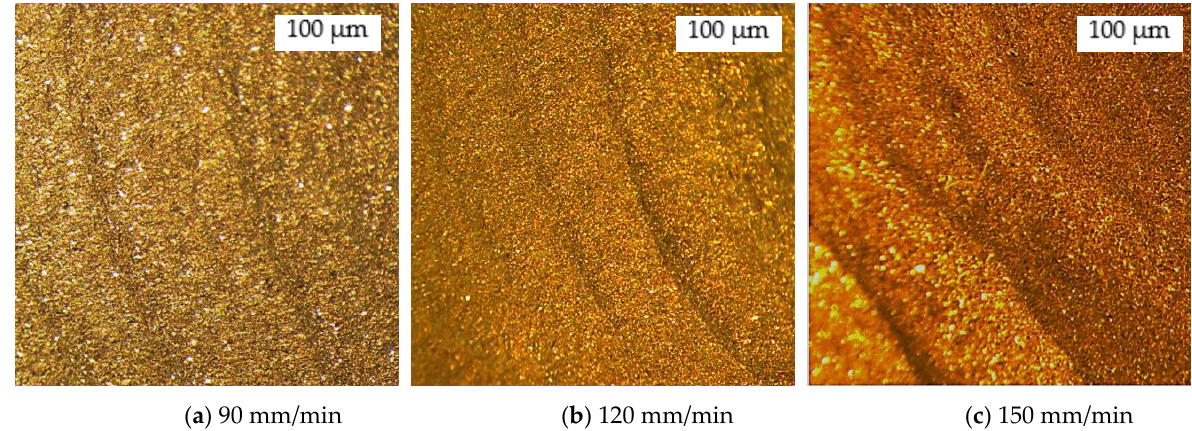
Figure 5. Topography of AISI 304L cut surface with 8 mm thickness using varied traverse speed.